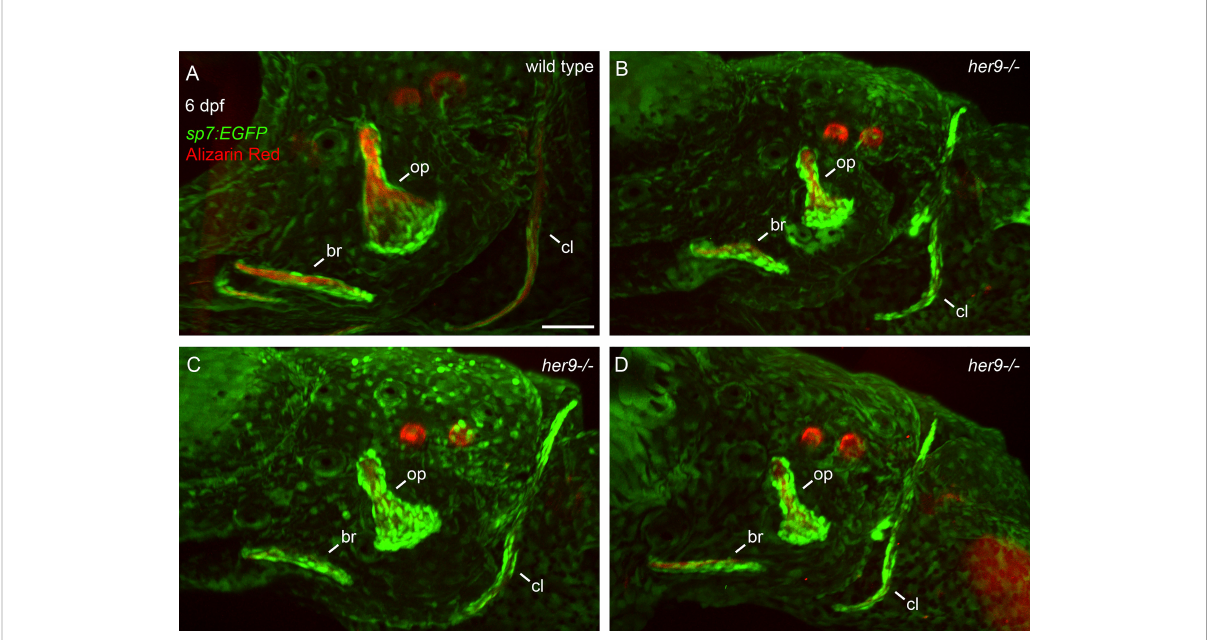
FIGURE 5 Opercle shapes are variable in her9 mutants. sp7:EGFP ; her9 heterozygotes were crossed to her9 heterozygotes and offspring were sorted for transgene expression. 24 live transgenic animals were labeled with Alizarin Red and imaged at 6 dpf. Imaged animals were genotyped. (A) Representative opercle region from a wild-type larva. (B – D) Three different her9 mutant larvae are shown. The following structures are indicated: opercle bone (op), branchiostegal ray (br), cleithrum (cl). Scale bar is 50 m m.